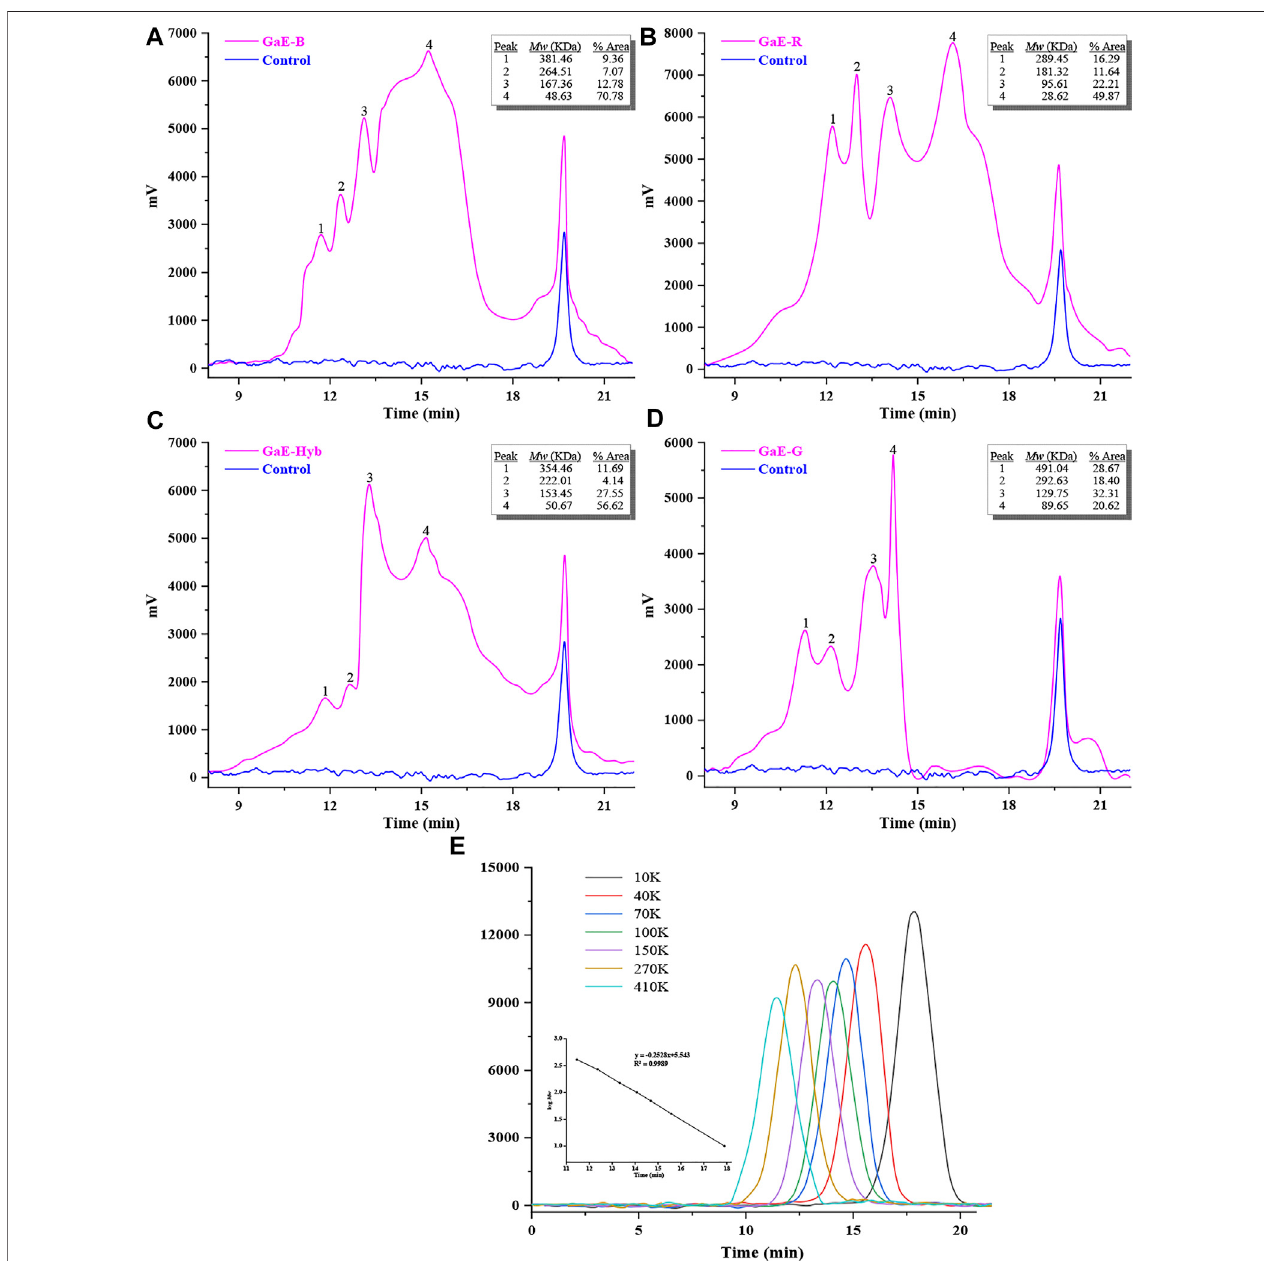
FIGURE 2 | Molecular weight of the Gastrodia elata polysaccharide with four varieties. (A) GaE-B; (B) GaE-R; (C) GaE-Hyb; (D) GaE-G; and (E) standard curve.